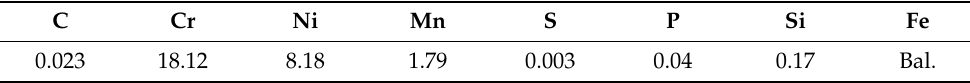
Figure 1. Backscattered electron image of initial microstructure: ( a ) Sanicro 25, ( b ) 304L. AISI 304L austenitic stainless steel, of chemical composition shown in Table 2, was provided in the form of a hot-rolled sheet. The original sheet was solution-treated at 1050 ◦ C for 30 min followed by cooling in nitrogen flow. The microstructure (shown in Figure 1b) consists of equiaxed austenitic grains with numerous annealing twins and delta ferrite stringers, aligned along the rolling direction, which occupied approximately 0.53% of volume fraction (measured by Feritscope MP30, Helmut Fisher GmbH, Sindelfingen, Germany). The average grain size measured by linear intercept method was 48 ± 32 µ m. Table 2. The chemical composition of 304L in wt.% provided by